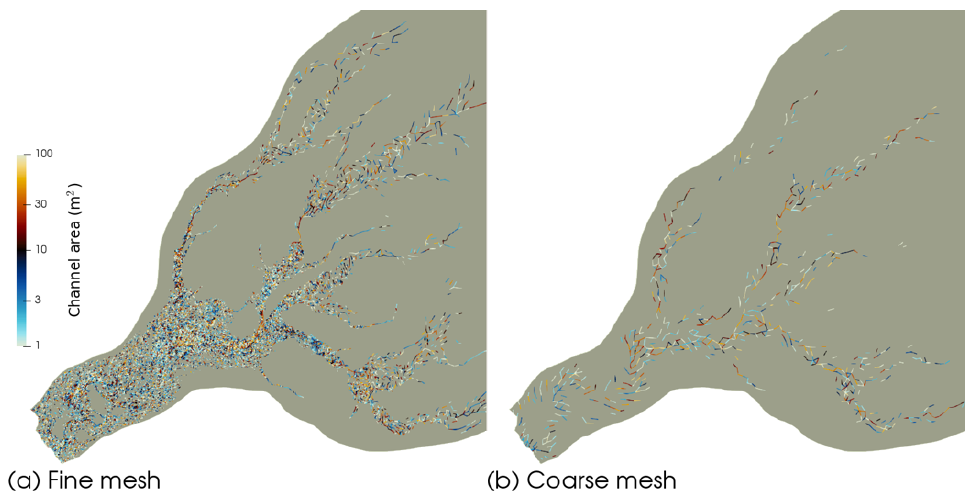
Figure 13. Comparison of hydrological model results for different mesh resolutions. (a) The standard, fine mesh described in Sect. 2.3; (b) a coarser, 500m resolution mesh. Note that the overall layout of the channel network is virtually identical between the